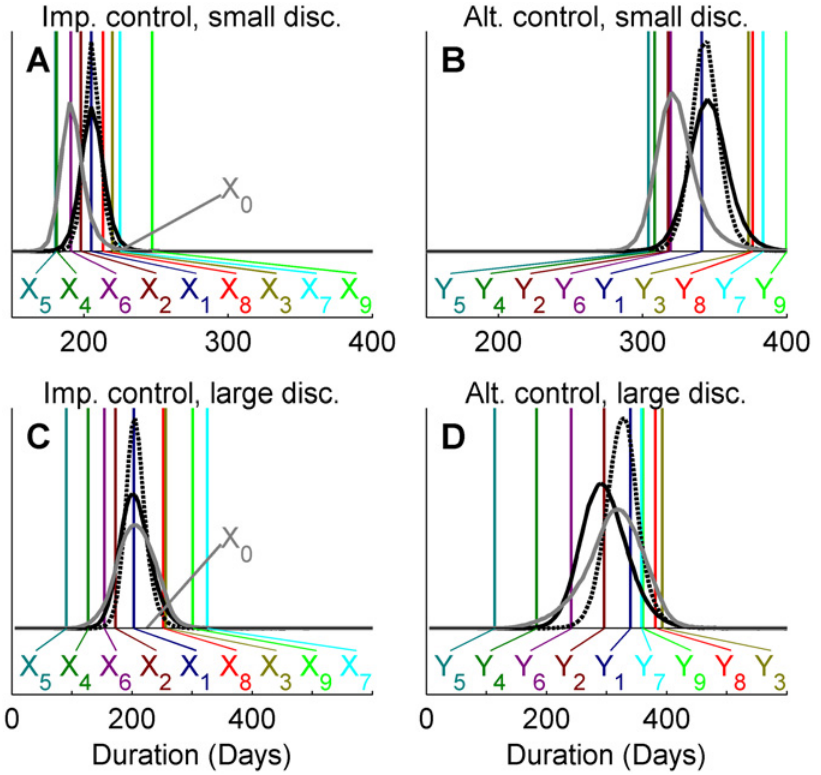
Fig 4. Ensemble prediction of expected outbreak duration with the IHW method. Panels A and C show ensemble estimates of mean duration for the implemented control action of the 2001 UK FMD outbreak under small and large discrepancy ensemble, respectively. Panels B and D shows the corresponding estimates for an alternative control action. Marginal posterior distributions indicate the expected outbreak duration estimated by the ensemble with a priori equal weights (solid black line), up-weighting of the most likely scenarios ( i = 1; dashed black line), up-weighting of the outlier ( i = 5; solid gray line). Observed outbreak duration is indicated by X0 and predicted means under the implemented and alternative control action are indicated by X1 , X2 , ... X9 and Y1 , Y2 , ... , Y9 ,